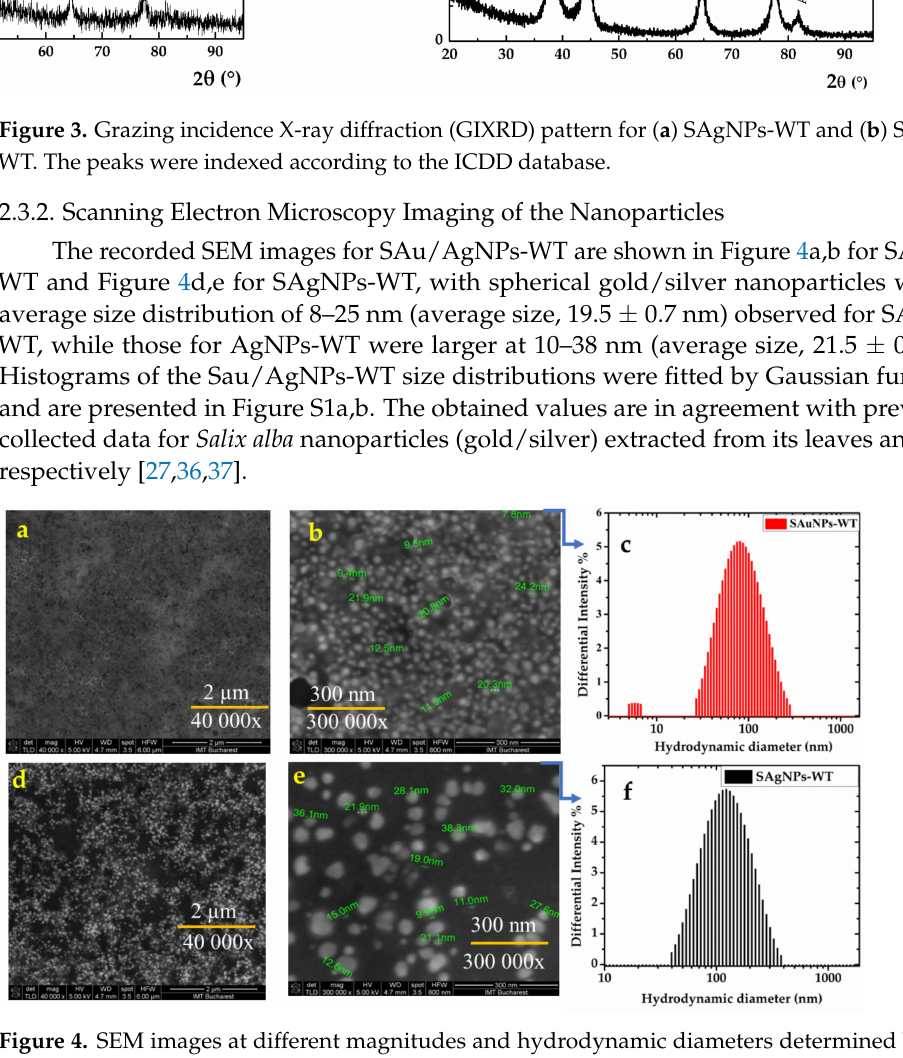
Figure 4. SEM images at different magnitudes and hydrodynamic diameters determined by DLS: ( a )—SAuNPs-WT (40,000 × ); ( b )—SAuNPs-WT (300,000 × ); ( c )—DLS of SAuNPs-WT; ( d )—SAgNPs- WT (40,000 × ); ( e )—SAgNPs-WT (300,000 × ); and ( f )—DLS of